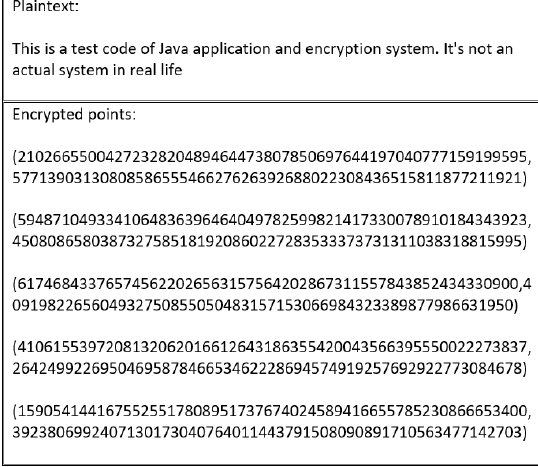
Figure 18. Cipher text generated by first encryption process using XOR with InV .